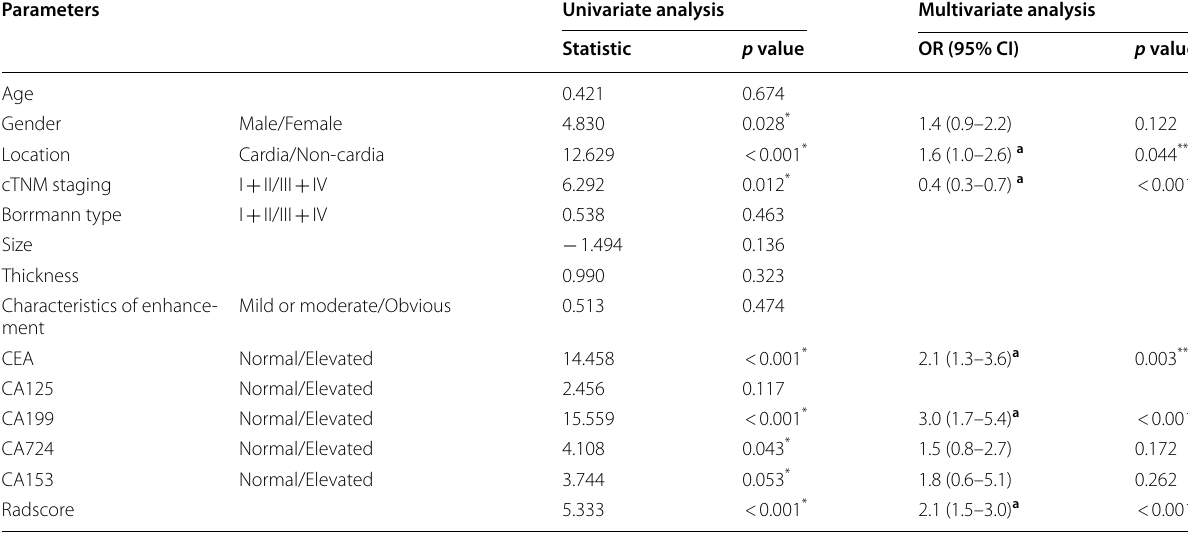
Table 3 Univariate analysis and multivariate logistic regression analysis of the clinical-laboratory characteristics and Radscore in training